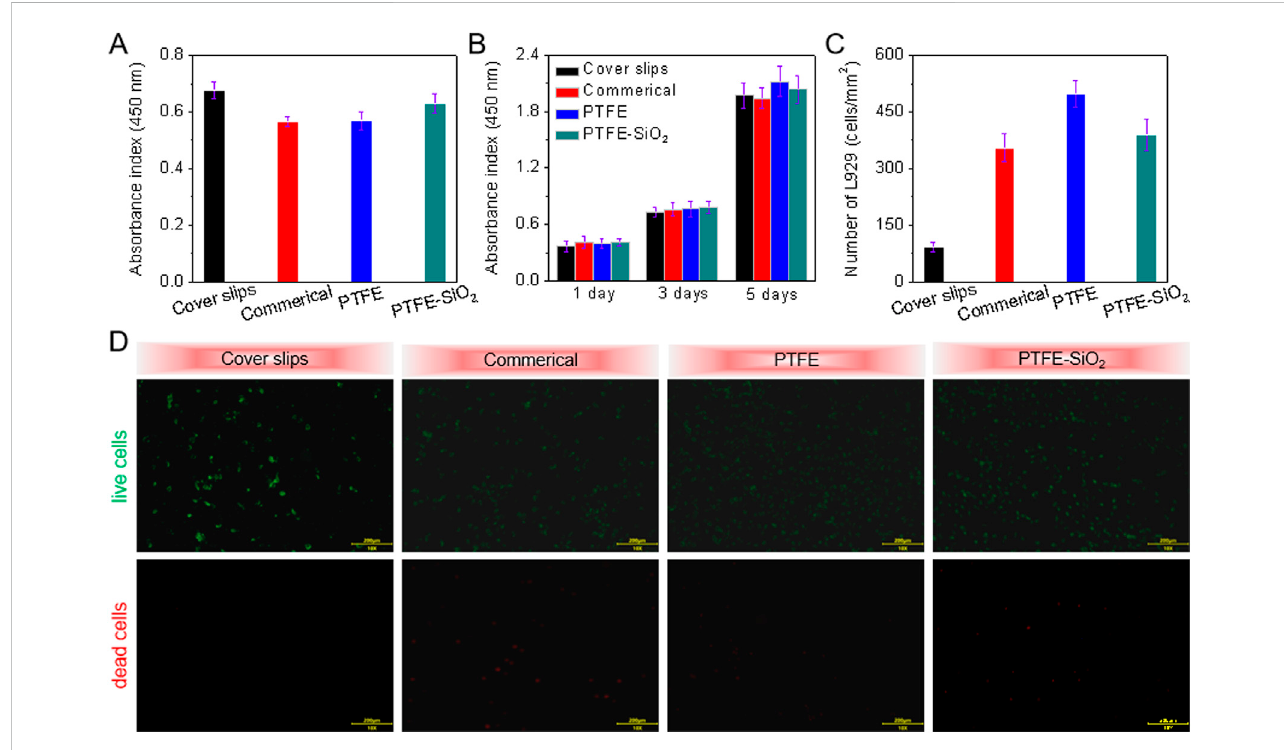
CCK-8 assay of (A) the adhesion viability after 24 h culture and (B) proliferation viability after 1, 3, and 5 days culture of HUVECs onto cover slips, commerical catheter, PTFE catheter, and PTFE-SiO 2 catheter, respectively; (C) Quantitative number measurements of L929 cells on the inner surfaces of cover slips, commerical catheter, PTFE catheter, and PTFE-SiO 2 catheter after culturing for 3 days; (D) Live/dead staining viability assay of L929 cells cultured on the inner surfaces of cover slips, commerical catheter, PTFE catheter, and PTFE-SiO 2 catheter after culturing for 3